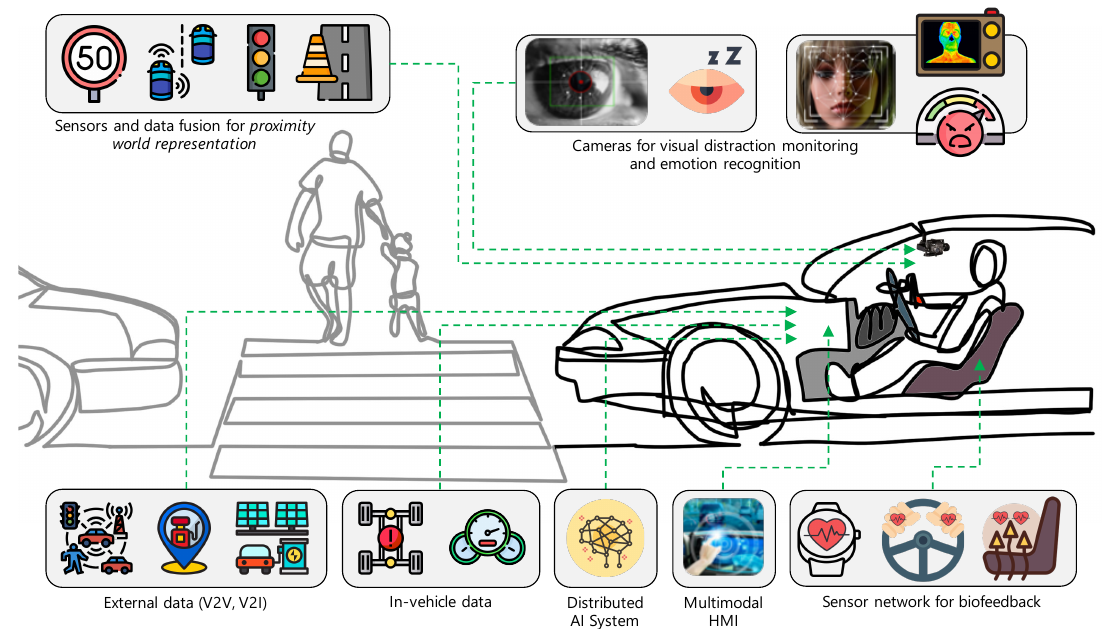
Figure 9. System architecture for the envisioned automotive Use Case (UC) in the NextPerception